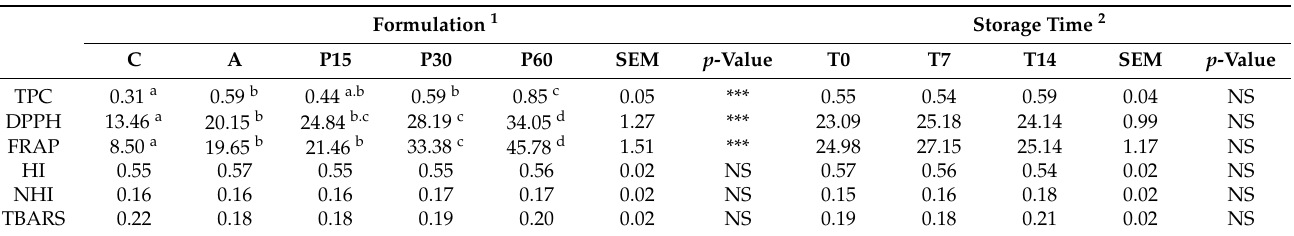
Table 2. Estimated marginal means and standard error of the mean (SEM) of total phenolic content (TPC, g GA eq. /kg), antioxidant capacities (DPPH and FRAP, mmol Trolox eq./kgdw), heme iron (HI, mg/100 g) and non-heme iron (NHI, mg/100 g), and lipid oxidation (TBARS; mg MDA eq./kg) of the raw pork